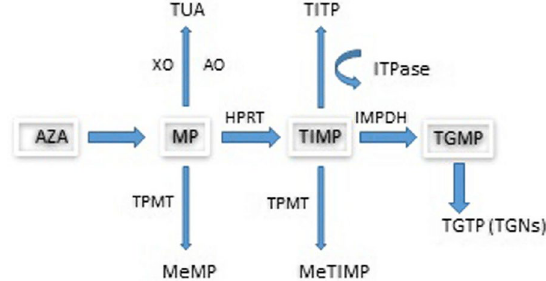
Fig. 2 Metabolism of AZA involves three pathways: the first is degradation to TUA which is then excreted, then through methylation by TPMT into MeMP, and breakdown of MP into TIMP catalyzed by HPRT. Then, TIMP is further metabolized via IMPDH into TGMP. Kinases convert this into the TGNs. Approximately 15–20% of patients with IBD demonstrate hypermethylation when treated with thiopurines. That means that during thiopurine metabolism, methylated thiopurine metabolites are preferentially produced instead of TGNs